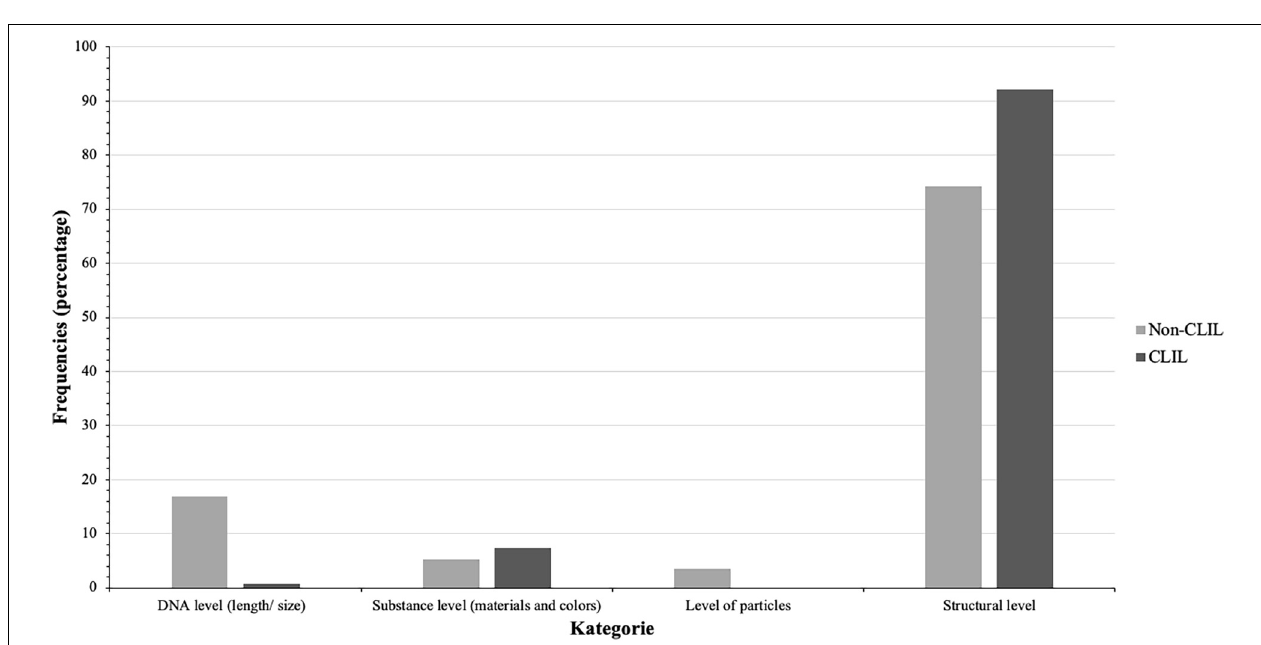
FIGURE 5 | Category frequencies of the open question “Which features of the original DNA molecule are simplified in your model” for non-CLIL and CLIL learners.